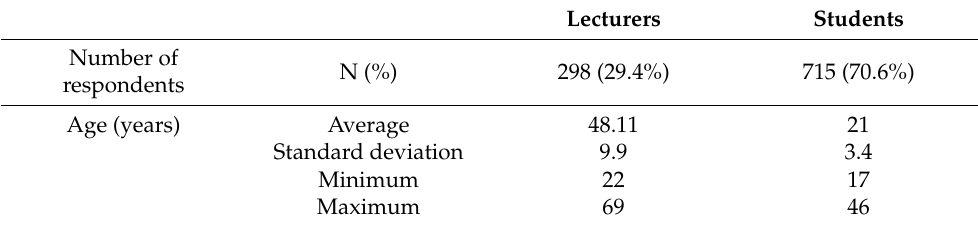
Table 3. Sample characteristics.